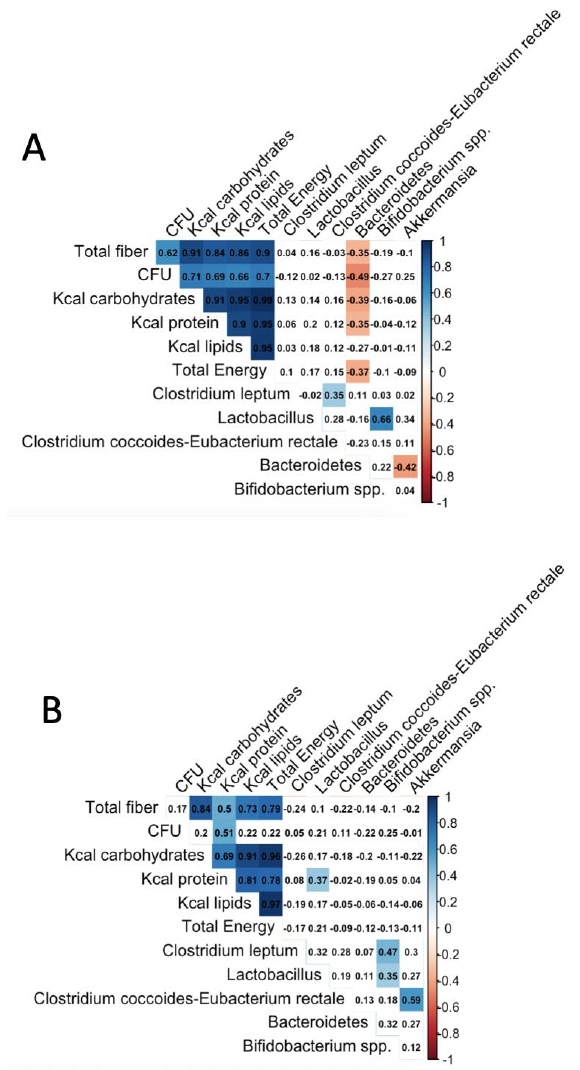
Figure 3. Spearman correlations between nutritional and microbial variables. ( A ) Normal-weight subjects, ( B ) overweight/obese subjects. Associations between dietary and microbial variables were tested using Spearman correlation; these associations have shown significant variables highlighted in red (negatively correlated) or blue (positively correlated), and findings were corrected for multiple testing using the Benjamini–Hochberg procedure [34], using the corrplot function from the R studio [35]. Abbreviations: BMI, body mass index; qPCR, quantitative polymerase chain reaction.